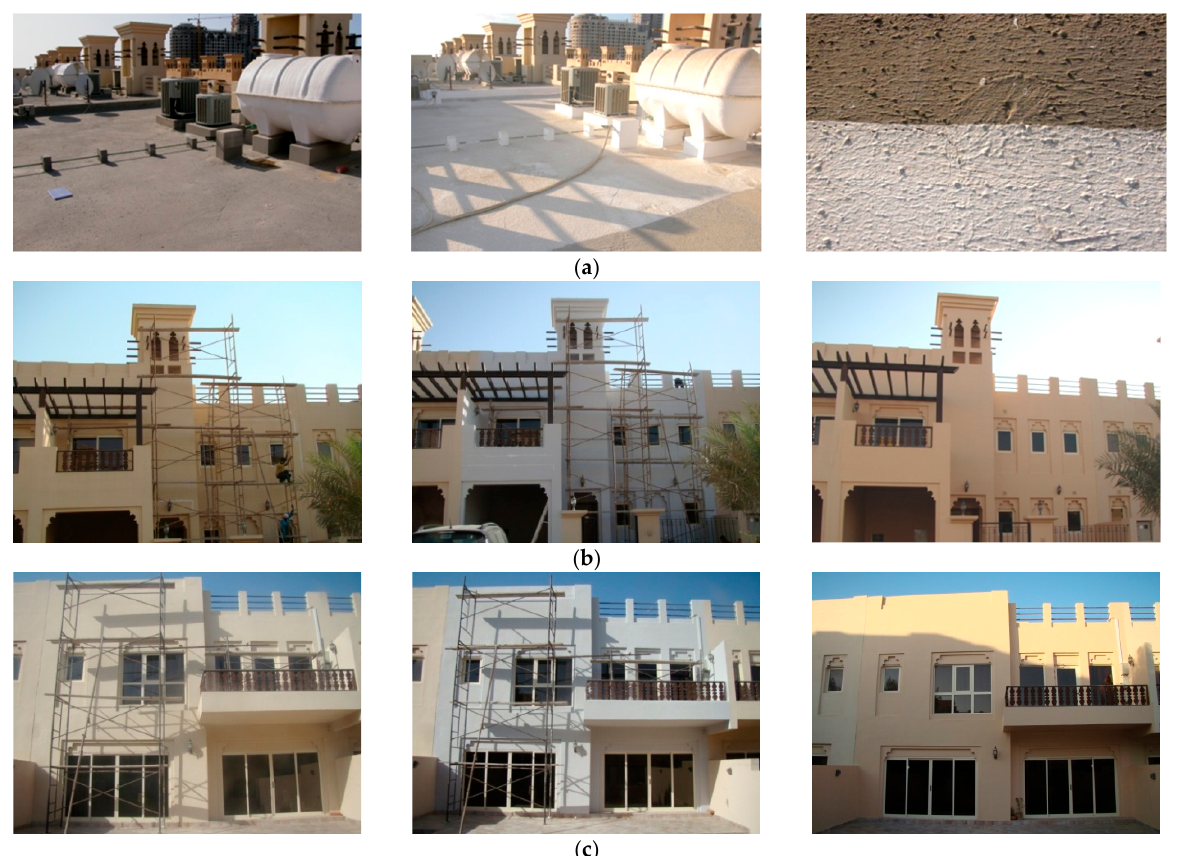
Figure 7. Picture showing retrofitting townhouse with cool roof and cool walls. ( a ) Roof coating: before (left) and after (middle); with and without SRI paint right). ( b ) Wall coating, front facade: before (left), after primer coating (middle) and after both top coatings (right). ( c ) Walls coating back facade: before (left), after primer coating (middle), and after both top coatings (right). Table 3. Construction characteristics of townhouse used in the study.